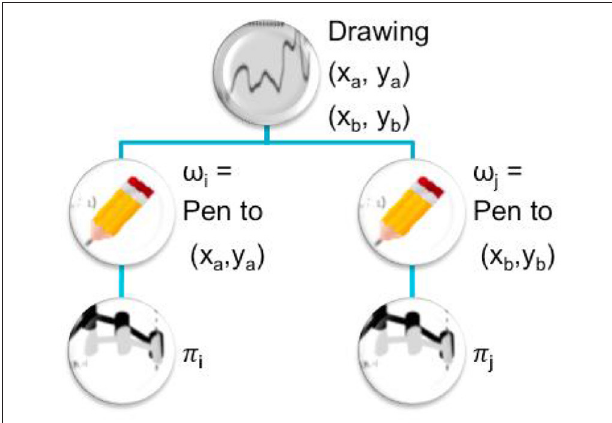
FIGURE 1 | Illustration of a procedure or task hierarchy. To make a drawing between points ( x a , y a ) and ( x b , y b ), a robot can recruit subtasks consisting in ( ω i ) moving the pen to ( x a , y a ), then ( ω j ) moving the pen to ( x b , y b ). These subtasks will be completed respectively with policies π i and π j . Therefore to complete the complete this drawing, the learning agent can use the sequence of actions ( π i , π j ).